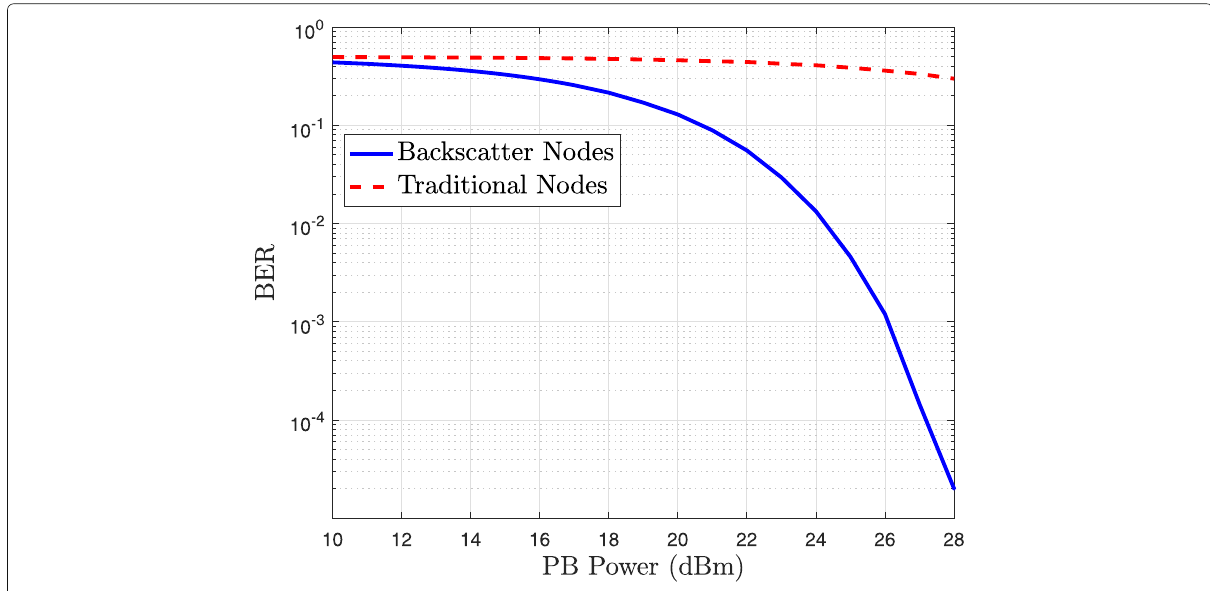
Fig. 10 BER versus PB